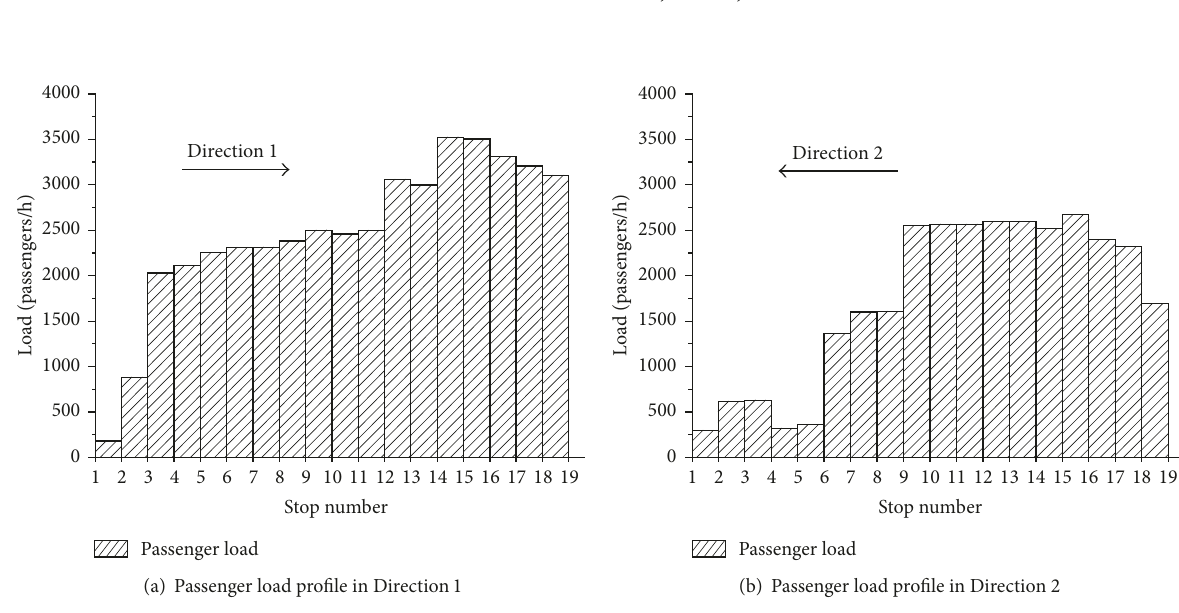
Figure 2: Passenger load profiles on bus Line 26.